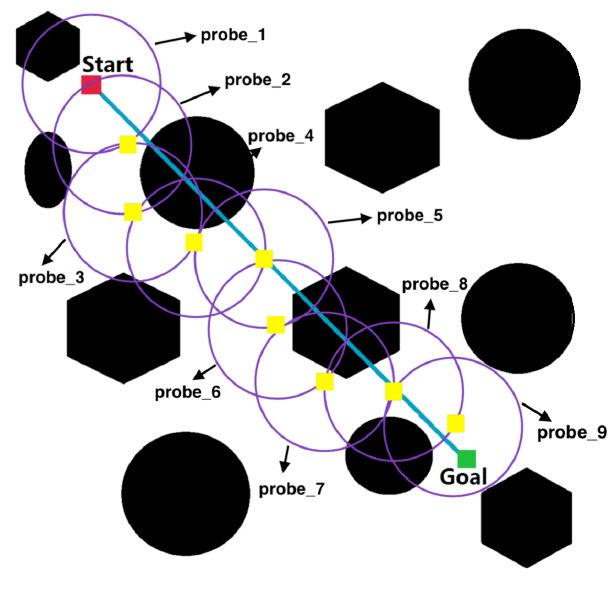
Figure 17. Detection range in unknown environments.